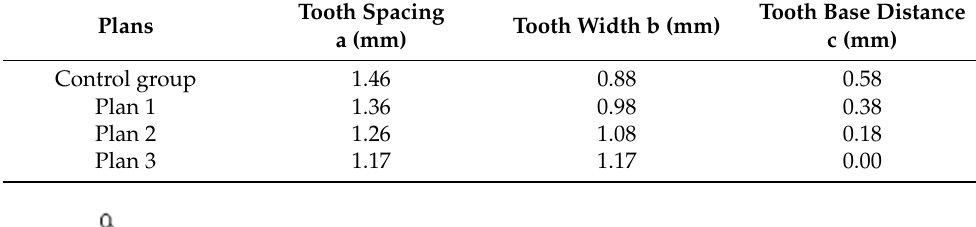
Table 3. Channel physical optimization plans of the emitter.